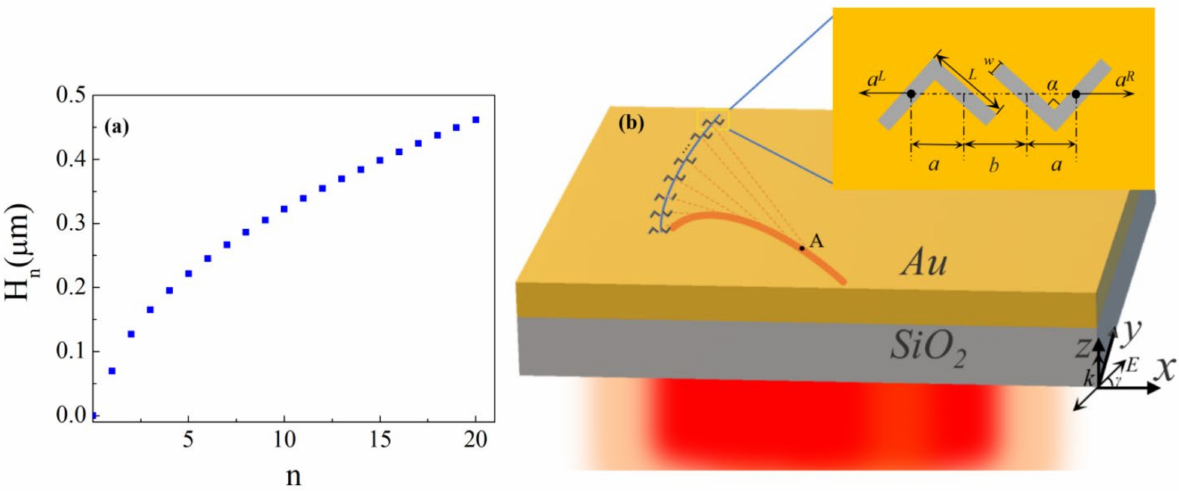
Figure 2. ( a ) The calculated distances H n of the n -th radiation source, ( b ) configuration of antisym- metric double V-shaped nanoslit